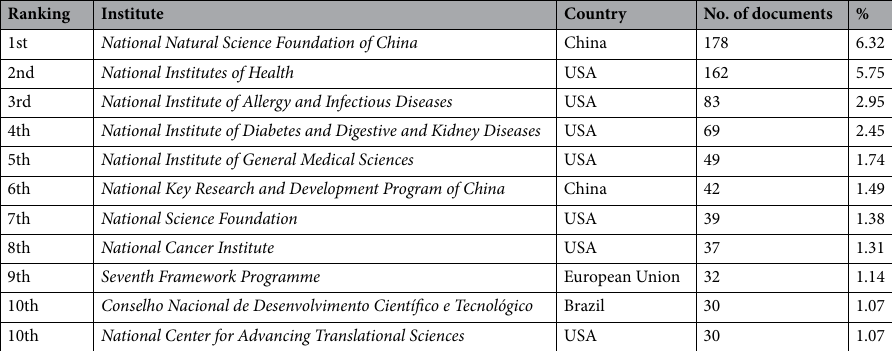
Table 3. Top ten active funding agencies for research related to the links between the microbiota and antibiotics from 2002 to 2021.